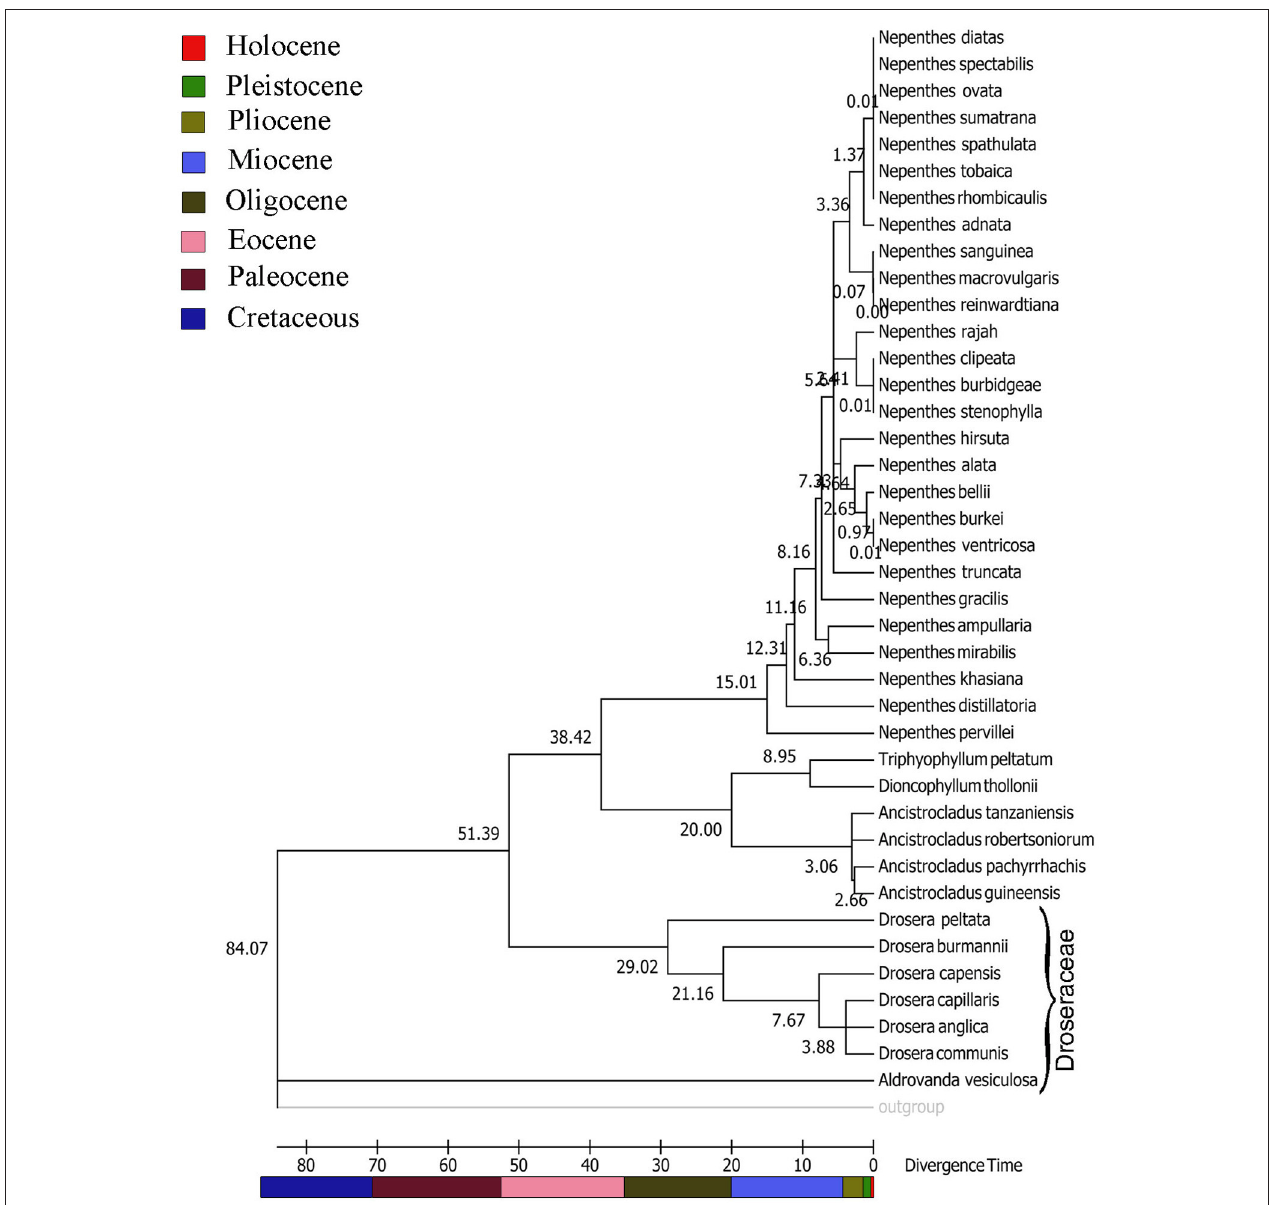
FIGURE 2 | Rel TimeTree chronogram for the combined dataset of matK and ITS showing divergence time estimation of Nepenthaceae from Droseraceae and evolution of the extant Nepenthes species. Divergence times for all branching points in the user-supplied calibrated topology were calculated using the Maximum Likelihood method based on the Tamura-Nei model. A discrete Gamma distribution was used to model evolutionary rate differences among sites (5 categories ( + G, parameter = 2.0910)). The rate variation model allowed for some sites to be evolutionarily invariable ([ + I], 0.0000% sites). Numbers at nodes are median ages in million of years (MYA) with two internal calibration points Evolutionary analyses were conducted in MEGA7.